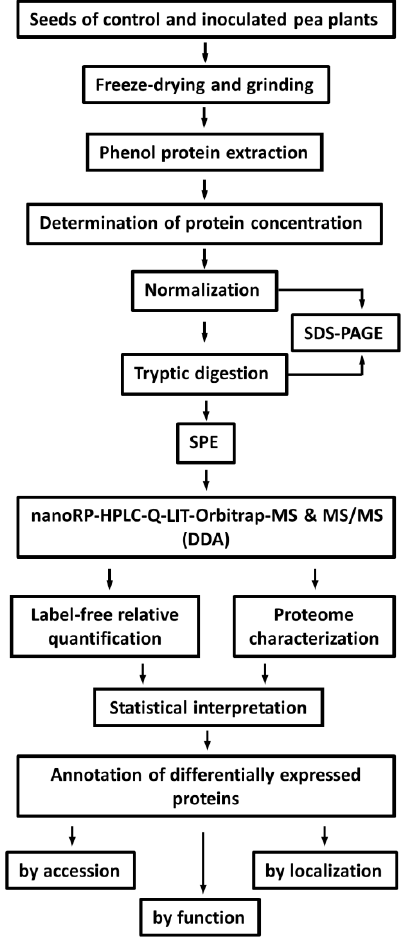
Figure 1. Experimental workflow for the analysis of a pea seed proteome.